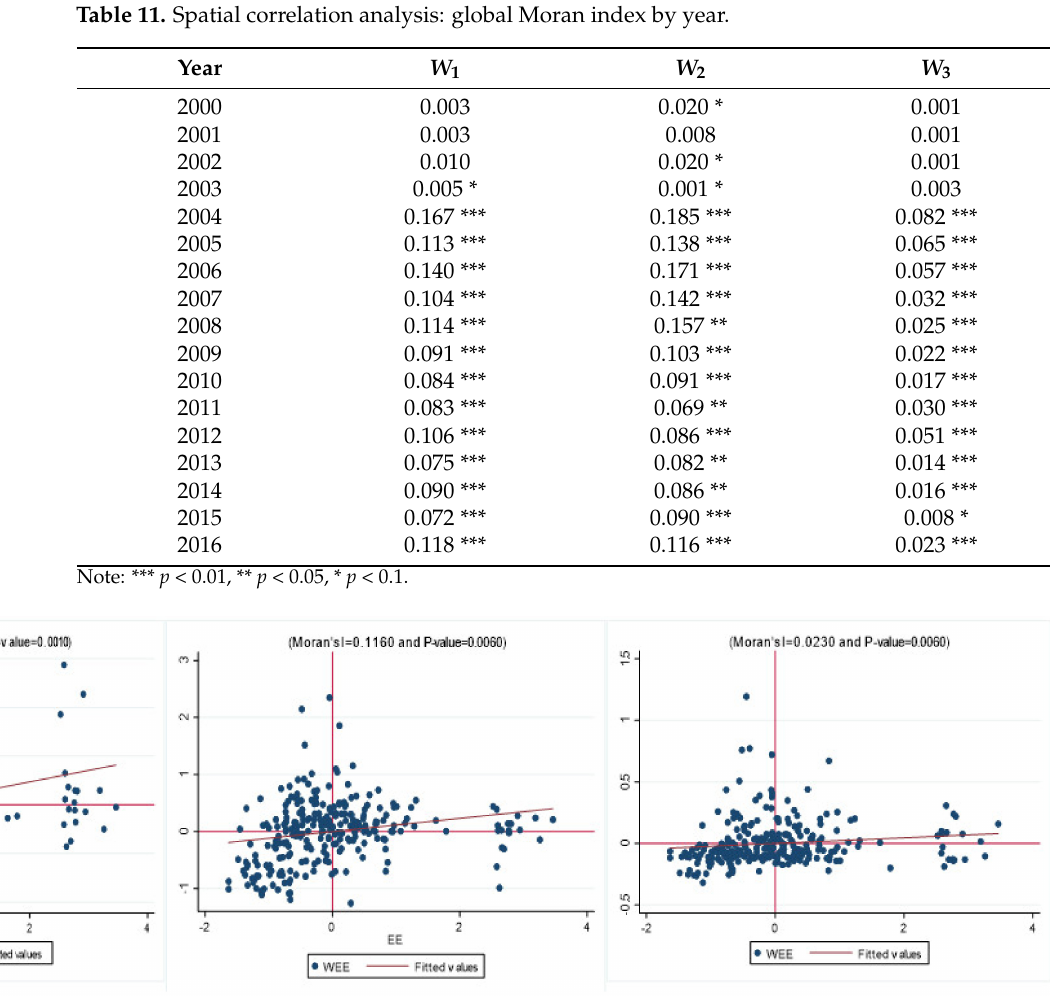
Figure 3. Moran scatter plot of EE for three matrixes (W 1 , W 2 , W 3